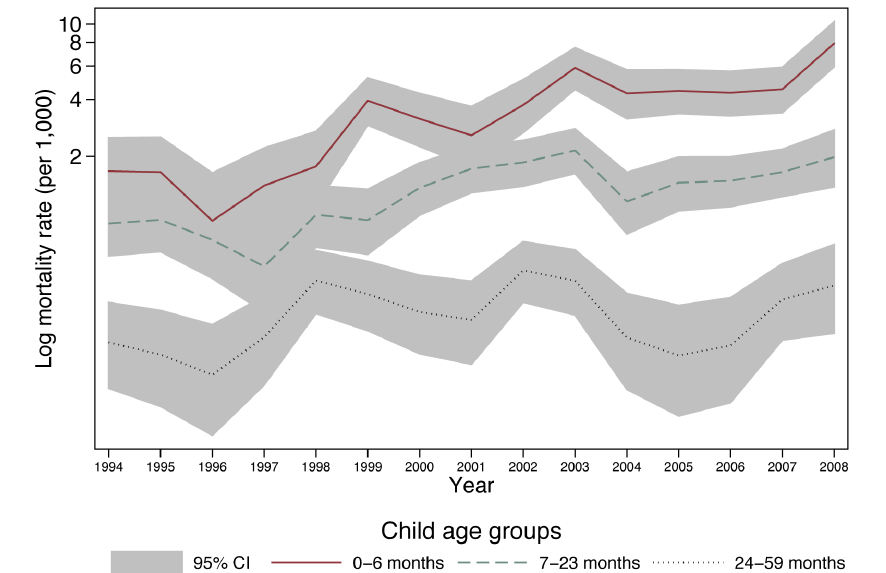
Figure 1. Child mortality rate in Agincourt sub-district, South Africa (1994–2008) by year and child age. Shading indicates Poisson 95% confidence intervals.